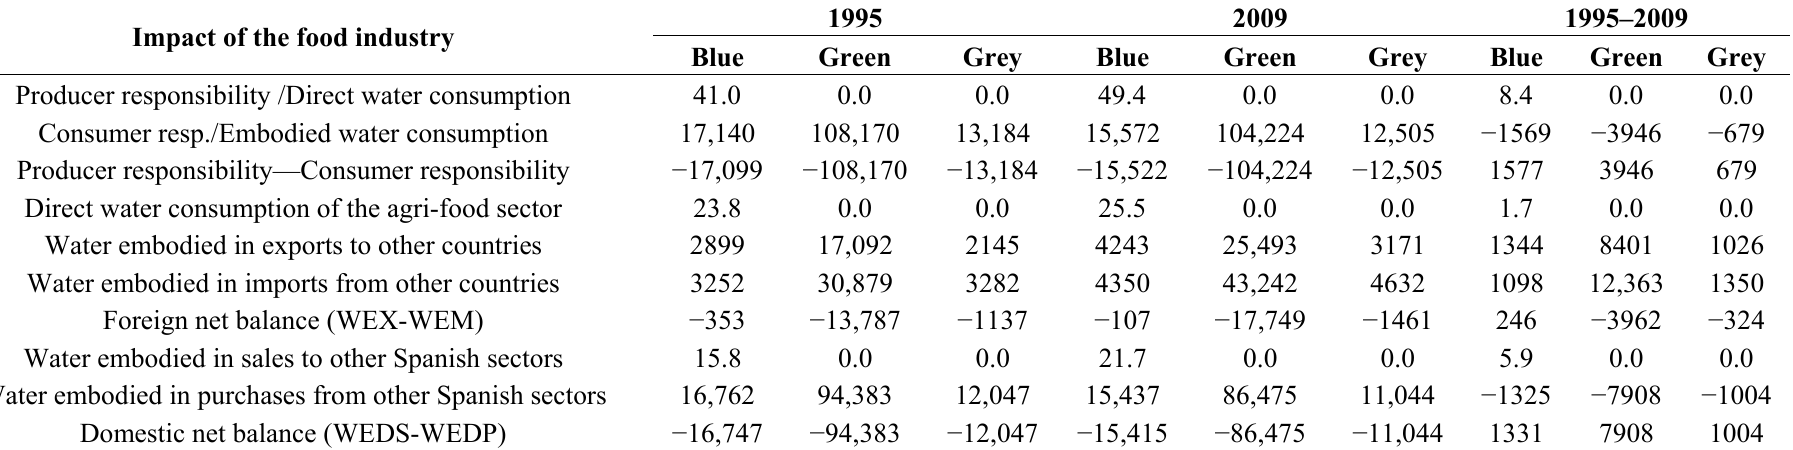
Table 2. The impact of the Spanish food industry on water resources, 1995–2009 (million m 3